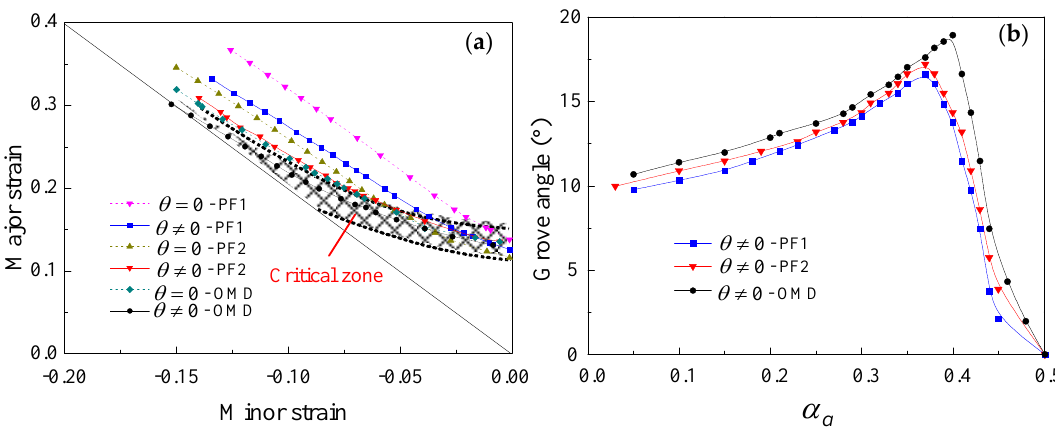
Figure 14. Effect of groove angle on FLCs. ( a ) FLCs under negative-strain paths. ( b ) Change of groove angle under different loading paths.